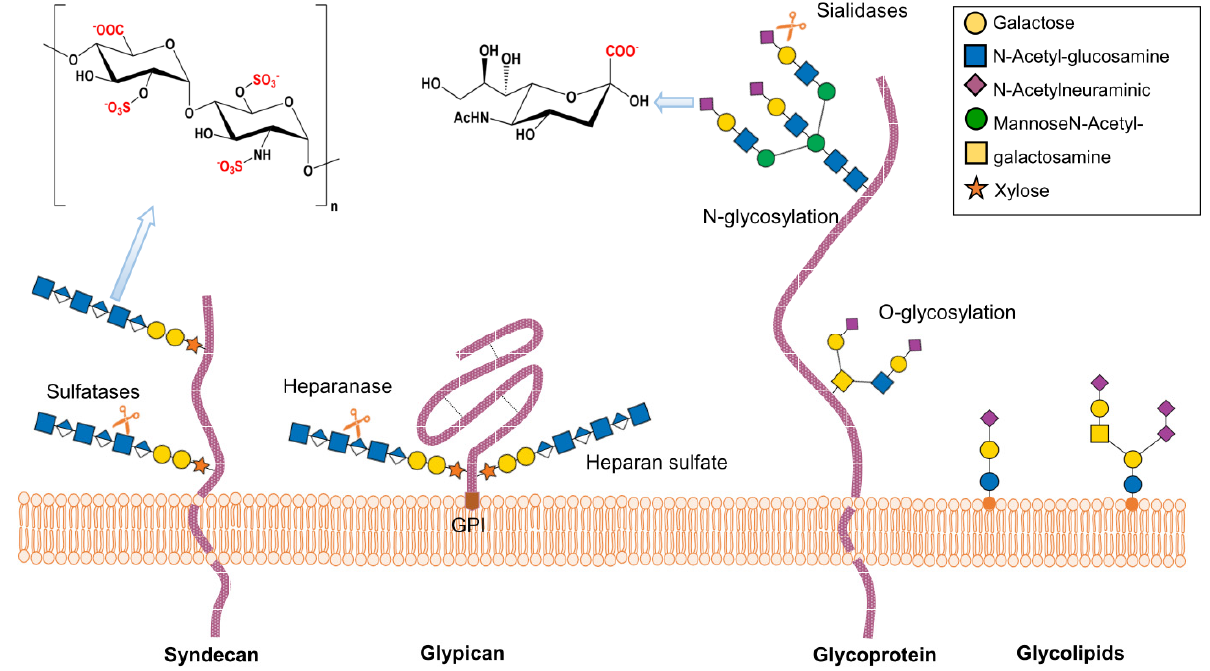
Figure 1. Schematic structure of heparan sulfate proteoglycan and sialic acid, the most important glycoconjugates that serve as viral receptors.